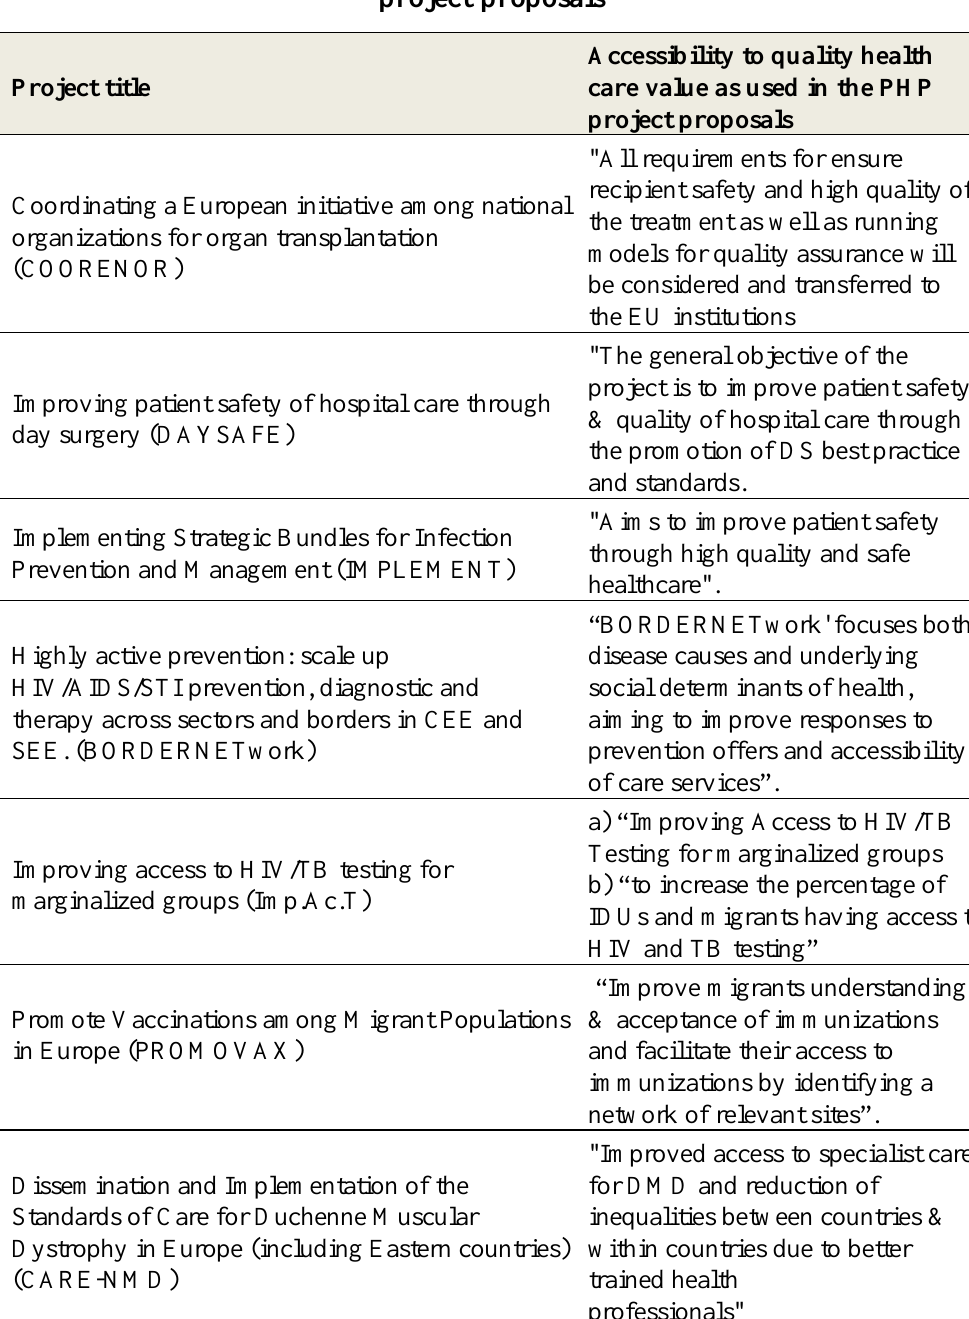
Table 5. Accessibility to quality health care as identified in the summaries of